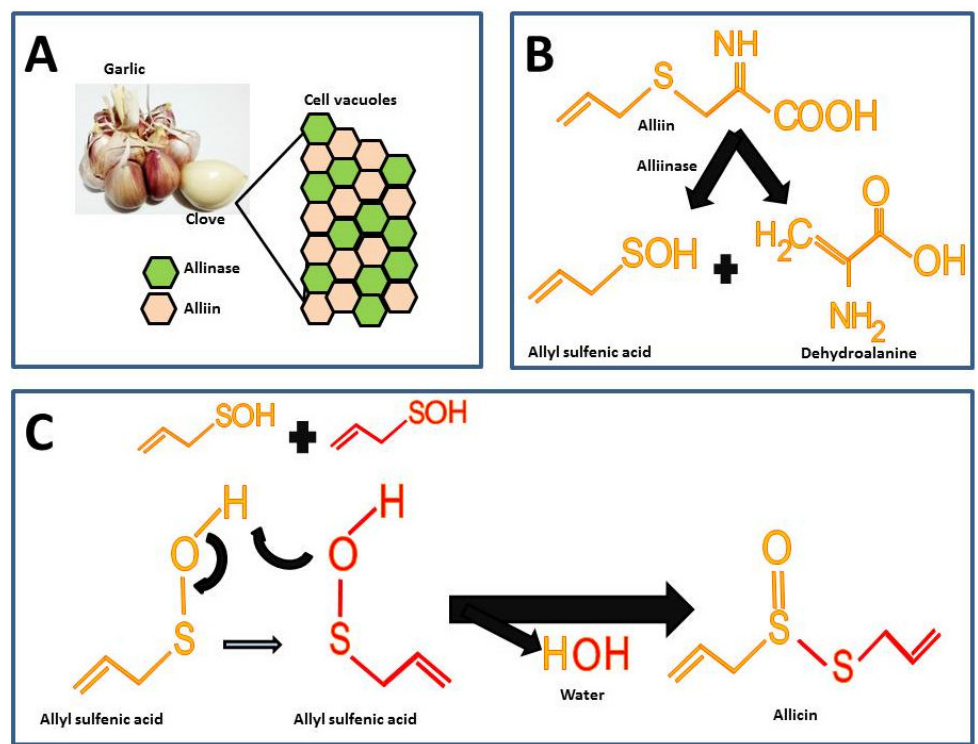
Figure 2. Chemical reactions for allicin synthesis in crushed garlic cloves and substrate formation for chemical synthesis: ( A ) Compartmentalization of alliin and alliinase in the intact garlic bulb; ( B ) First reaction in allicin formation; ( C ) Second reaction for the allicin formation.